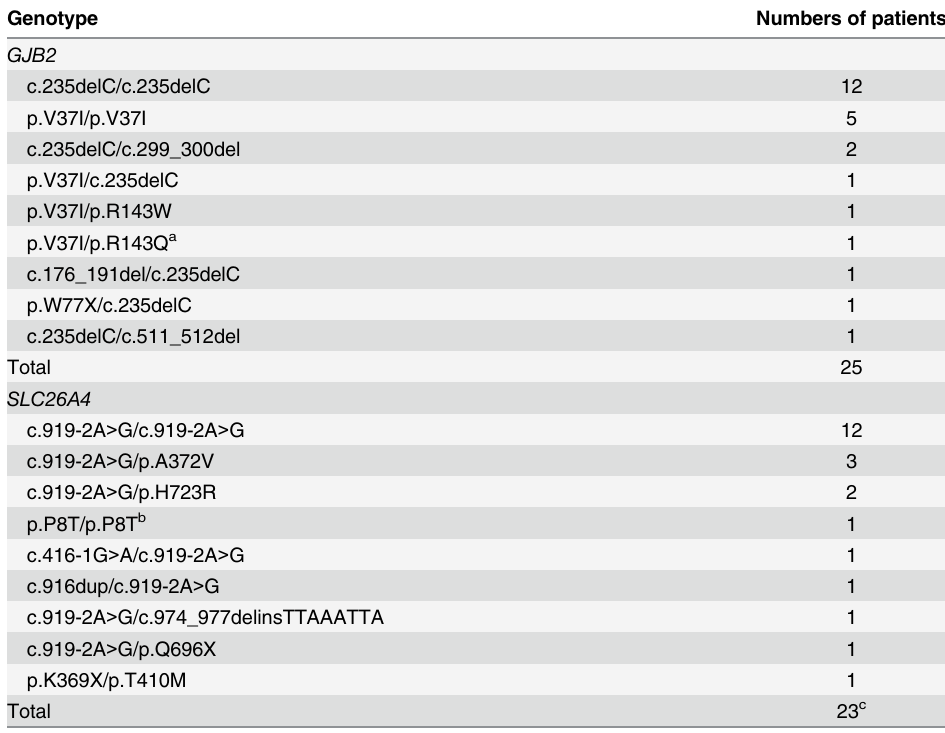
Table 2. Genotypes of the 48 children with mutations in common deafness